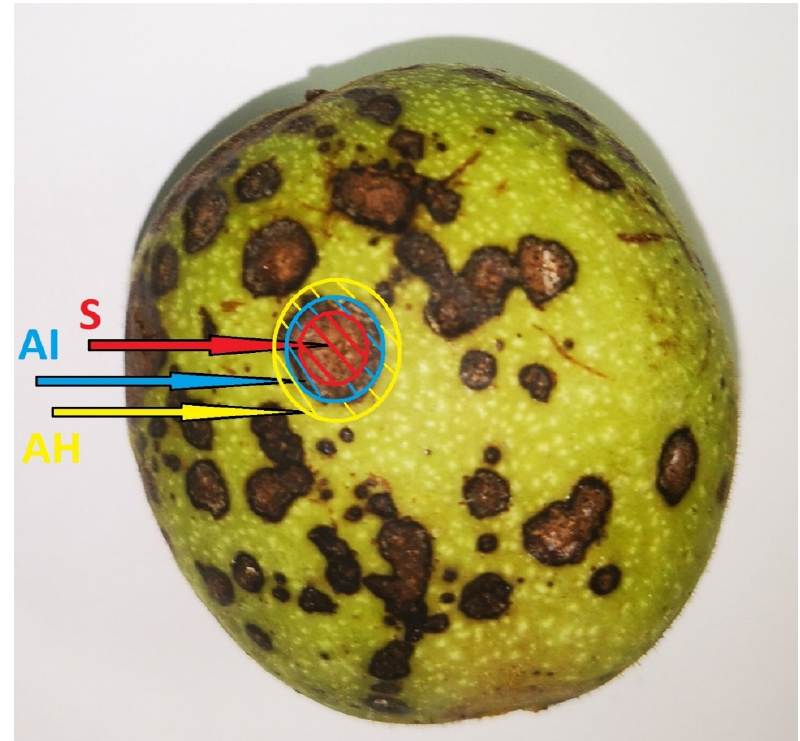
Figure 1. Different parts of walnut tissue were sampled. Red circle (S): inner spot of infected tissue; blue circle (AI): outer margin of infected tissue; yellow circle (AH): healthy tissue surrounding the infection.